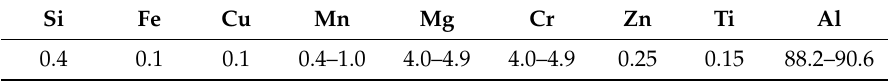
Table 1. Chemical composition of 5083 aluminum alloy element.